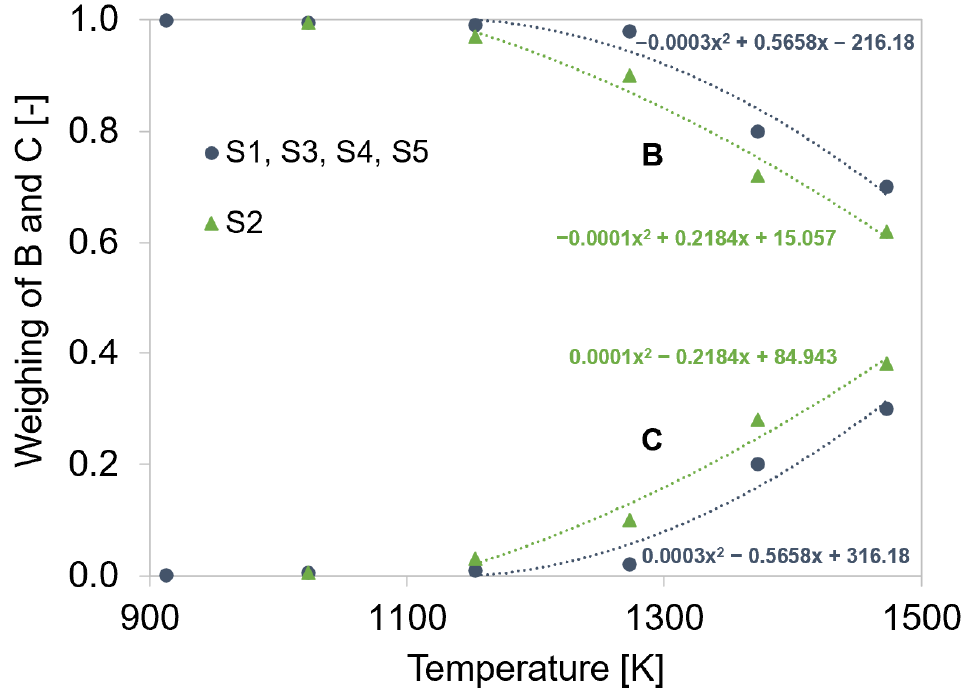
Figure 9. Temperature-dependent experimental weighing factor for parameters B and C.